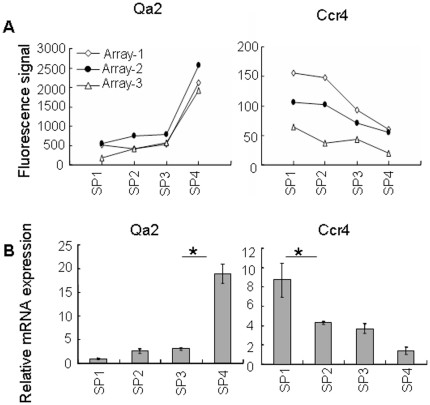
General validation of gene expression.(A) Gene expressions of Qa2 and Ccr4 in the four thymocyte subsets are revealed by the microarray analysis. (B) Quantitative RT-PCR results of Qa2 and Ccr4 transcripts in the four thymocyte subsets. Asterisks indicate significant (P<0.05) changes in each two-subset comparison. The experiment was performed for three times and similar results were obtained.